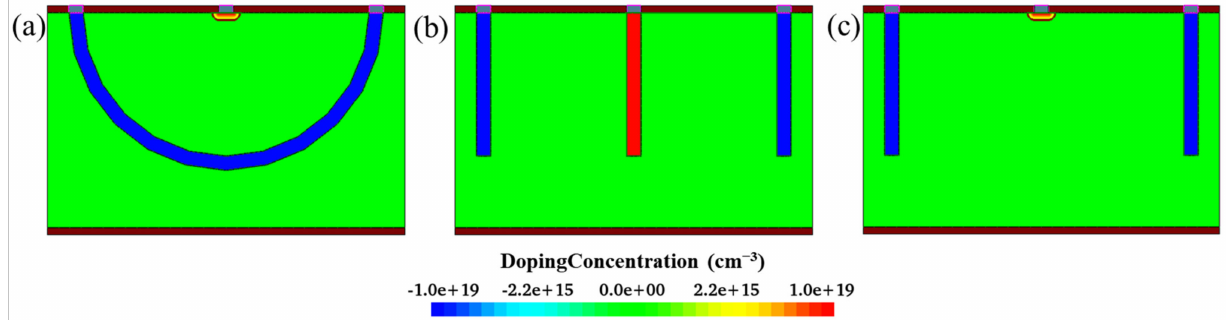
Figure 17. Comparison of different device structures; ( a ) The hemispherical electrode detector; ( b ) 3D trench detector with column collecting electrode; ( c ) 3D trench detector with dot collecting